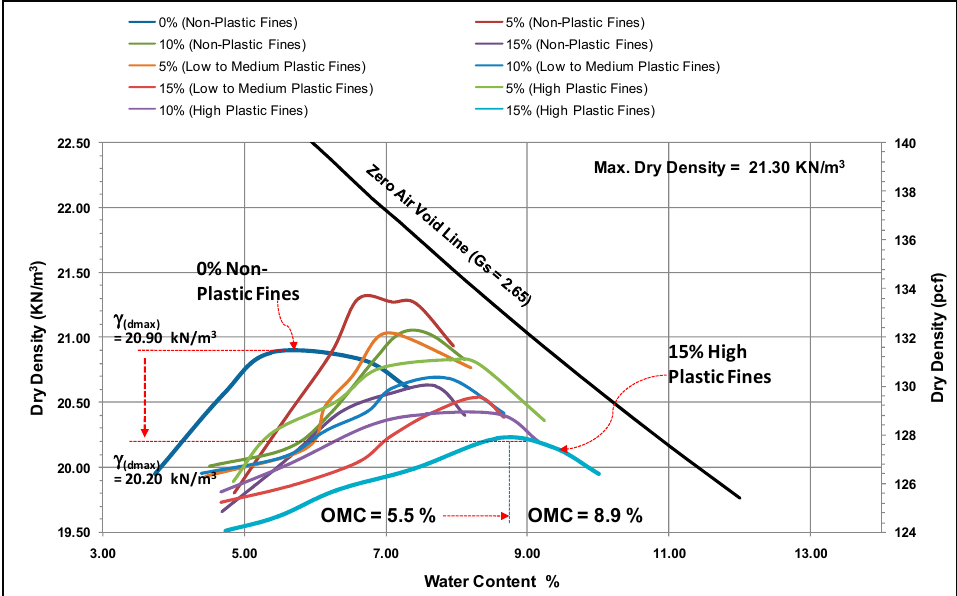
Figure 3. Compaction curves of the composite samples (gradation C).